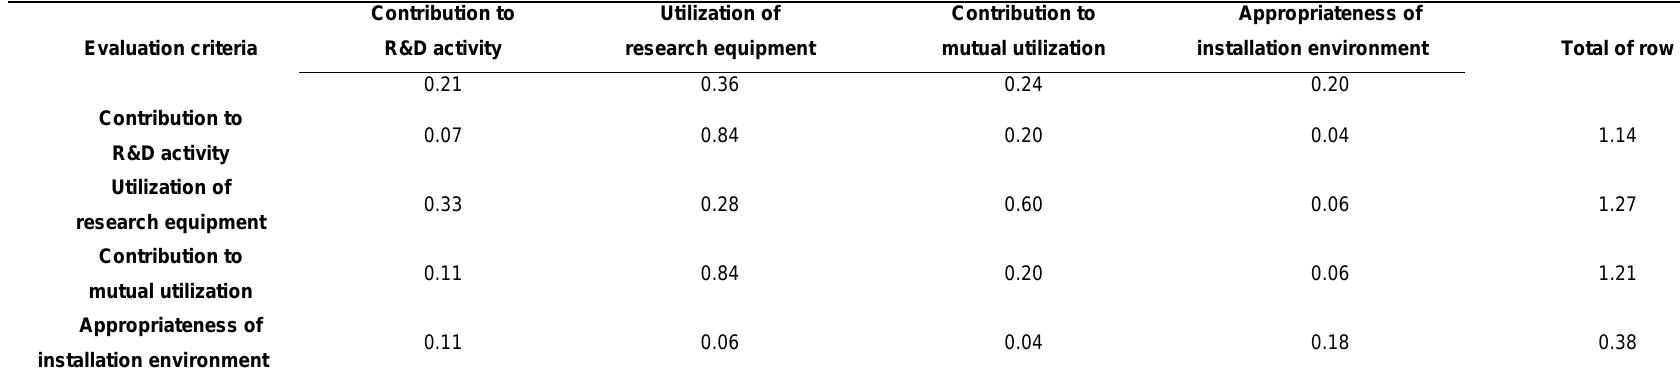
Table 15. Calculation of weight